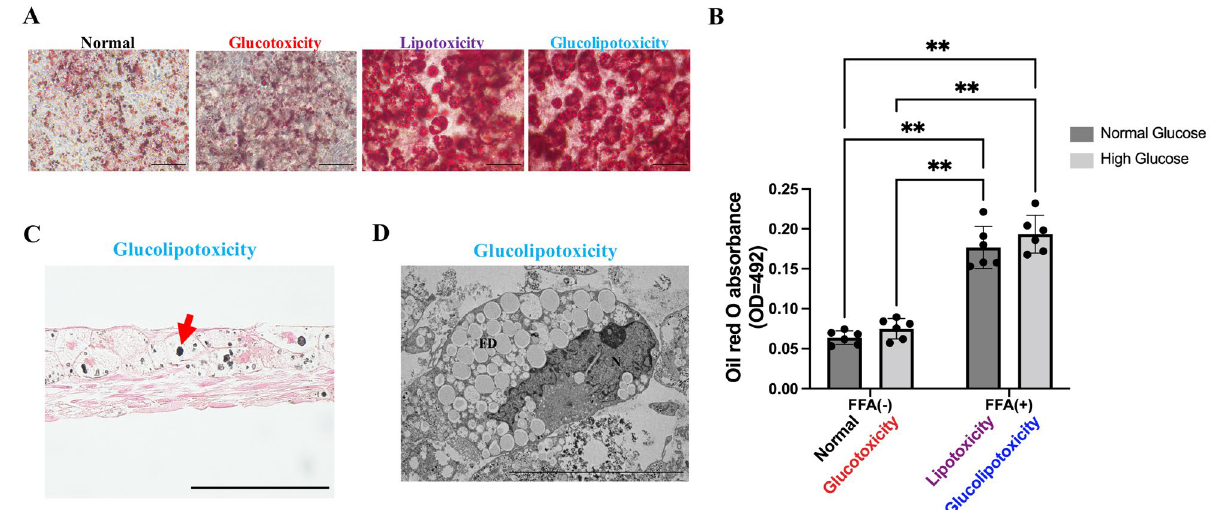
Figure 4. Evaluation of fat drop. ( A ) Representative images of oil red O staining. Scale bar, 200 μm. ( B ) Quantification of oil red O staining. Lipotoxicity and glucolipotoxicity groups showed significantly more oil red O accumulation than control and glucotoxicity groups, n = 6, 3 independent experiments, ** p < 0.01. ( C ) Representative images of fat drops (Osmium method). Red arrow indicates fat drop. Scale bar, 100 μm. ( D ) Representative images of TEM. Fat accumulation was observed in the glucolipotoxicity group. Scale bar, 10 μm. N: nuclear, FD: fat